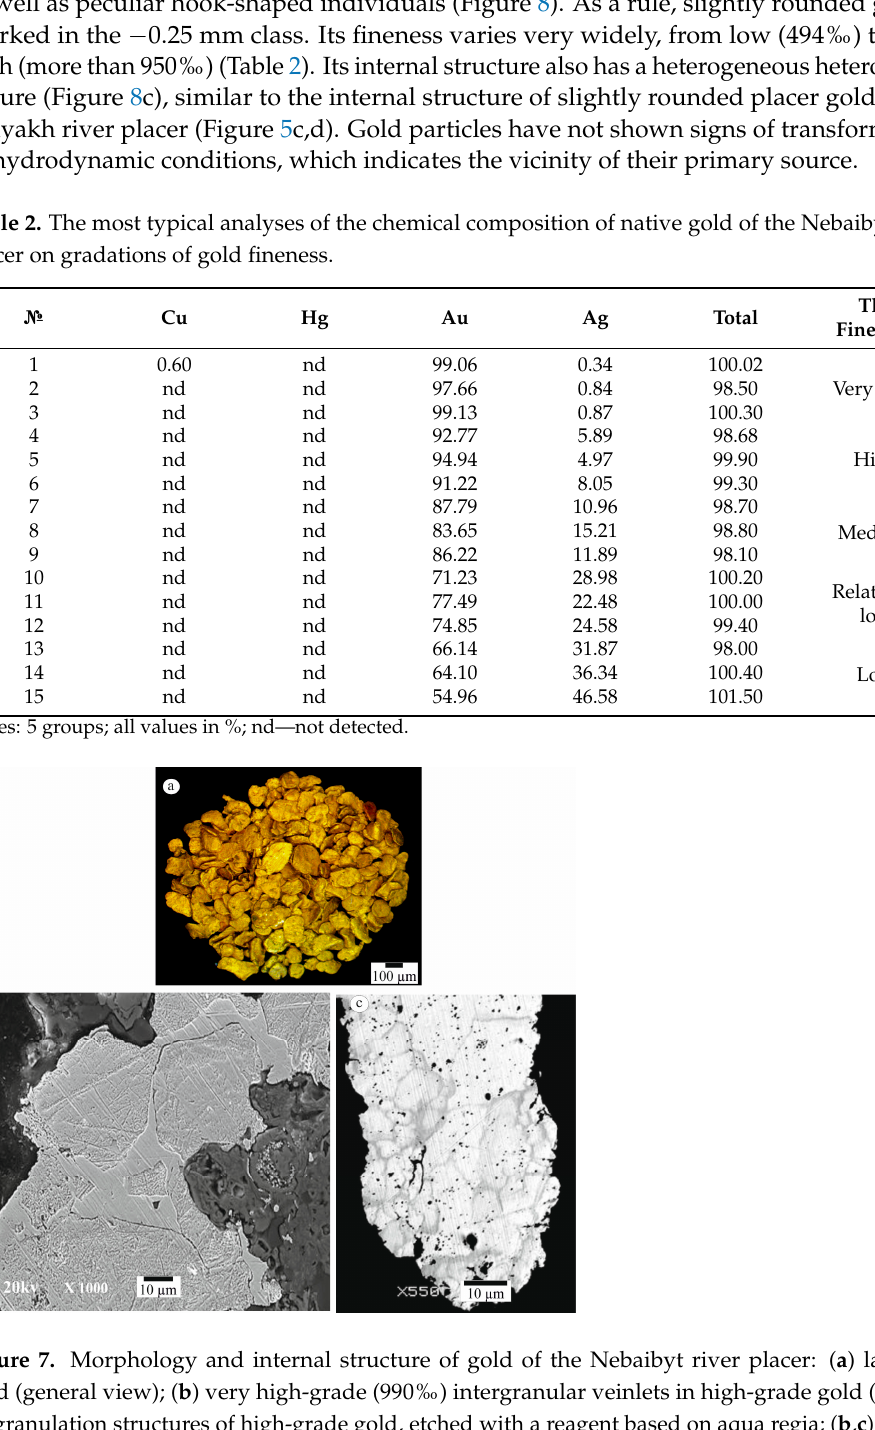
Figure 8. Morphology and internal structure of slightly rounded native gold of the Nebaibyt river placer: ( а , b ) slightly rounded gold; ( c ) block nature of the internal structure of multiphase gold, etched with a reagent based on aqua regia; ( a , b ) shot in SEI mode; ( c ) shot in BSE mode. No mineral inclusions were found in gold except for small inclusions of quar tz . Since at this stage of research, in gold of the placers of the Billyakh and Neibabyt rivers no ore inclusions were found, we provide data on mineral inclusions in gold of the Mayat river placer, which was studied by us earlier [6,8]. The Mayat river joins the Ana- bar river just north of the Billyakh river and fl ows almost parallel to it (Figure 2). The fi neness of gold of the Mayat river varies widely: 951‰–999‰, 35%; 950‰– 900‰, 15%; 800‰–899‰, 30%; 700‰–799‰, 10%; and 400‰–699‰, 10%. Inclusions of pyrite, arsenopyrite, galena, quar tz , and potassium feldspar were found in slightly rounded gold with a grain size of more than 0.5 mm (Figure 9).